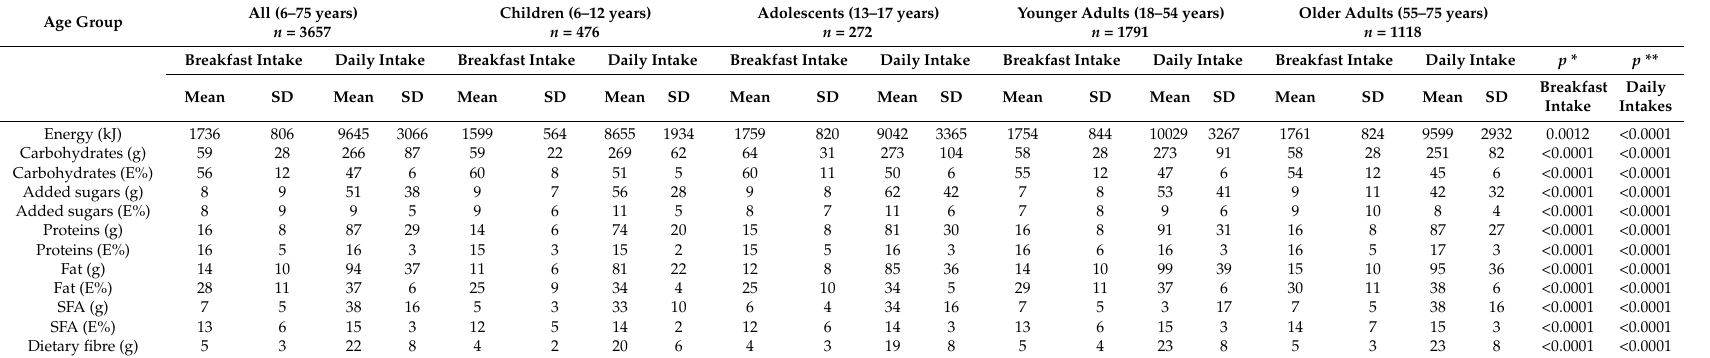
Table 2. The intake of energy and macronutrients at breakfast and for the total day according to age in Danes